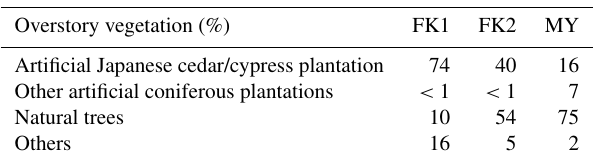
Table 1. Plant information for each forested catchment (Chiwa,